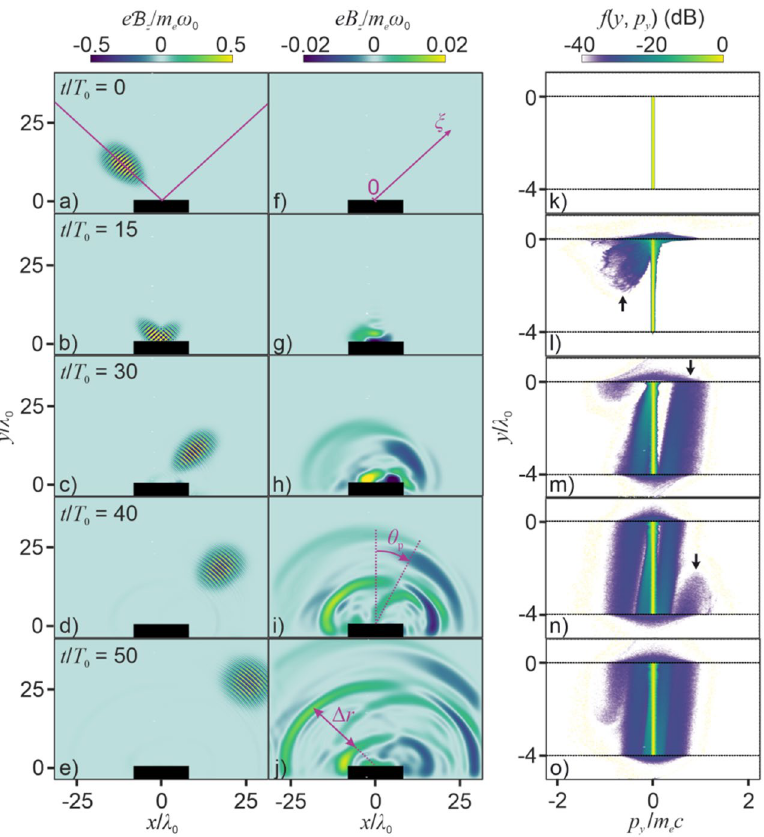
Figure 1. ( a – j ) Spatial distributions of ( a – e ) the overall field B z ( x , y ) and ( f – j ) the THz-filtered field B z ( x , y ) and ( k – o ) electron y – p y phase-space distributions f ( y , p y ) for a plasma slab with l y = 4 λ 0 driven by a p -polarized field with a